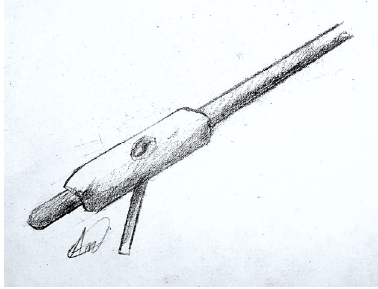
Figure 10. Modified AO technique using a flexible nail introduced into distal slot.